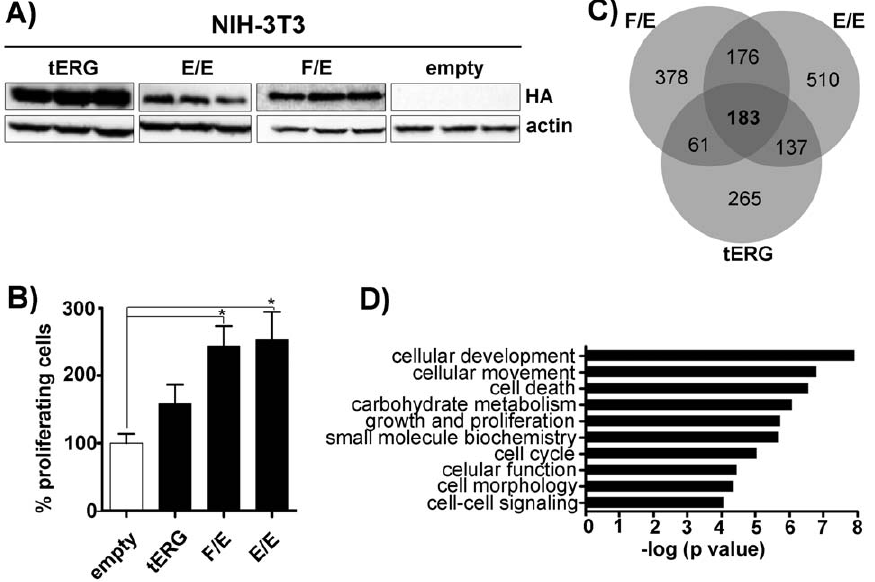
Figure 1. Overexpression of HA-tagged TMPRSS2/ERG (tERG), EWS/ERG (E/E) and FUS/ERG (F/E) in NIH-3T3 cells. a ) Anti-HA immunoblot of NIH-3T3 whole cell lysates. Each transfection was performed in triplicate. Actin was used as a loading control. b ) Evaluation of NIH-3T3 proliferative activity through [3H]Thymidine incorporation assay after 48 hrs of growth. Data for each ERG form represent the average of the results of the three independent populations and are normalized against the average of NIH-3T3_empty vector cells (*p , 0.05). c ) Venn diagrams of the transcription profiles of NIH-3T3 transfectants considering genes with a cut-off $ 1.5 fold differential expression compared to control cells (NIH3T3- empty). d ) Graphic representation of the top 10 highly significant molecular and cellular function categories identified by the common 183 deregulated genes. Categories ranking was obtained by Ingenuity Pathway Software. Significance refers to the 2 log(p-value), which was obtained by the Ingenuity program using a right-tailed Fisher’s exact test.